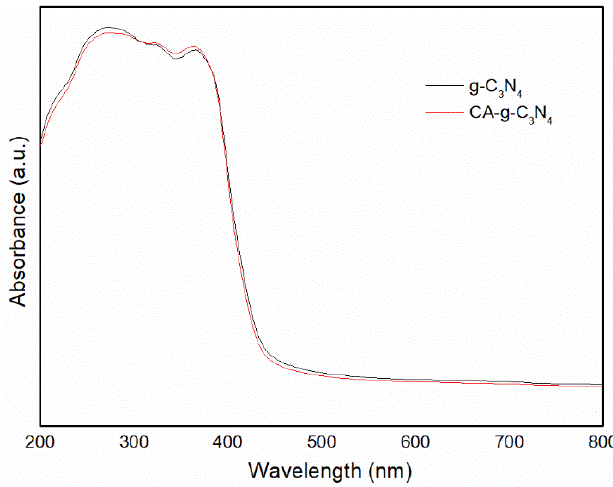
Figure 4. UV-vis of g-C 3 N 4 and CA-g-C 3 N 4.